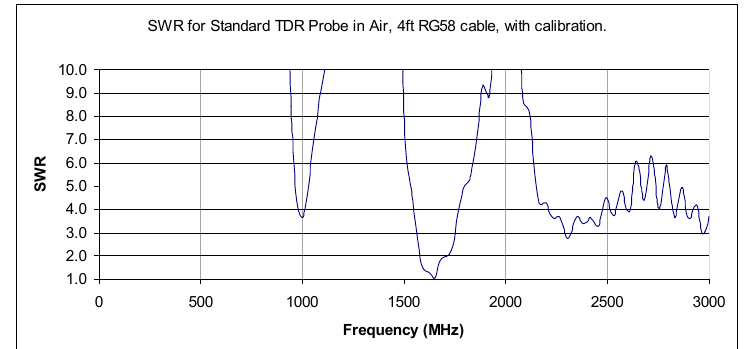
Figure 4. Frequency response of typical 20 cm TDR probe in air. We note that the “SWR” plot is typically used for antenna design as it clearly shows when energy is being lost from the system and is being radiated out into